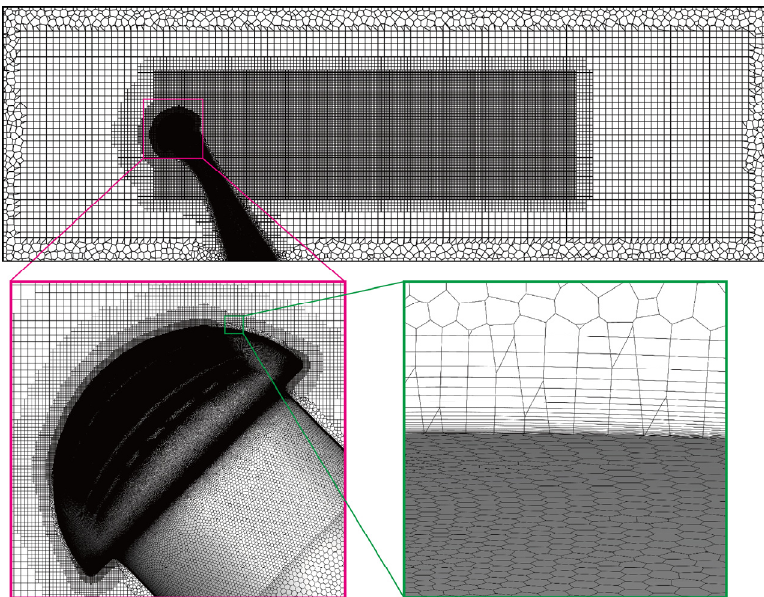
Figure 4. The schematic of the mesh in the computational domain.